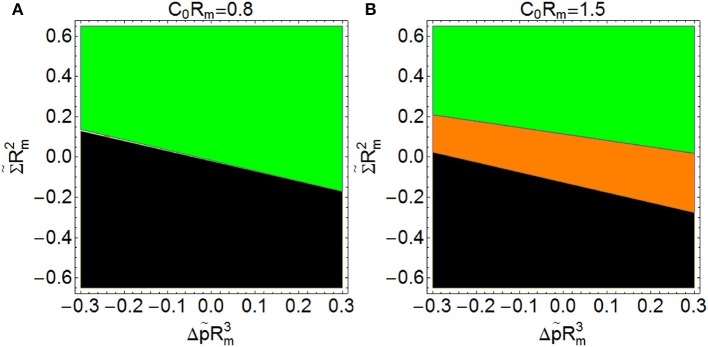
Constriction force at the beginning of constriction (s = 0.2) as a function of Σ~Rm2(y-axis) and Δp~Rm3 (x-axis) with C0Rm = 0.8 (A) and with C0Rm = 1.5 (B). (
Fc > 0: Non-spontaneous constriction, 
Fc < 0: Spontaneous constriction, 
Fc imaginary: impossible constriction). The regions shaded in green correspond to the cases in which an external force is required for constriction. The region shaded in orange corresponds to conditions leading to spontaneous constriction (negative constriction forces). Finally, the regions shaded in black correspond to conditions under which constriction is impossible (imaginary analytical results and no numerical solution. If C0Rm > 1, it is possible to get spontaneous constriction for a certain range of the products Σ~Rm2 and Δp~Rm3, but if C0Rm < 1 there is no combination of surface tension and osmotic pressure leading to spontaneous constriction.